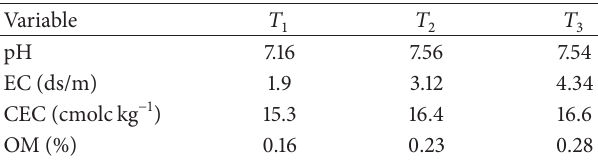
Table 2: Some variable properties of soil due to addition of manure in different levels at the end of incubation